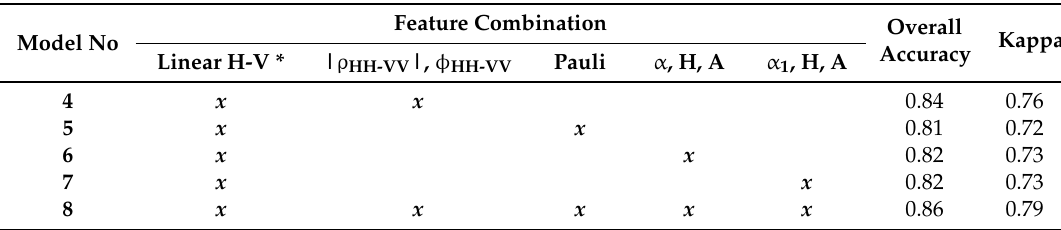
Table 7. Classification accuracy measures when different polarimetric features were added to the H-V linear quad-pol data.